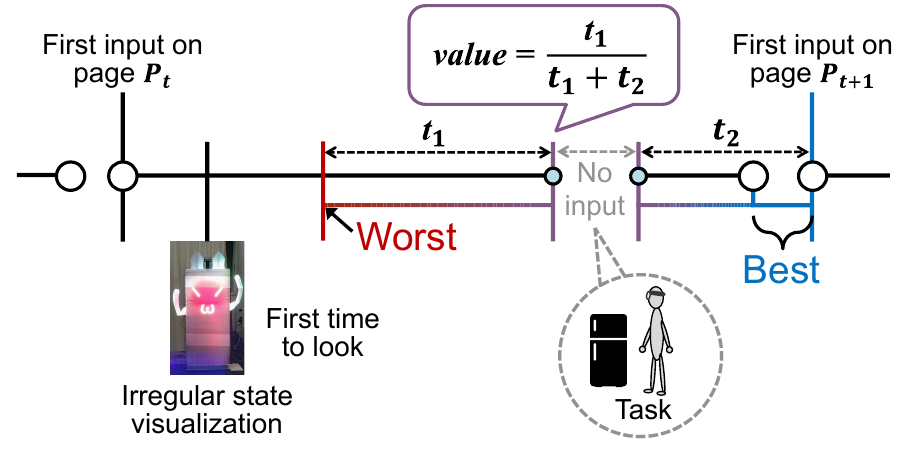
Figure 7. Evaluation of action timing.